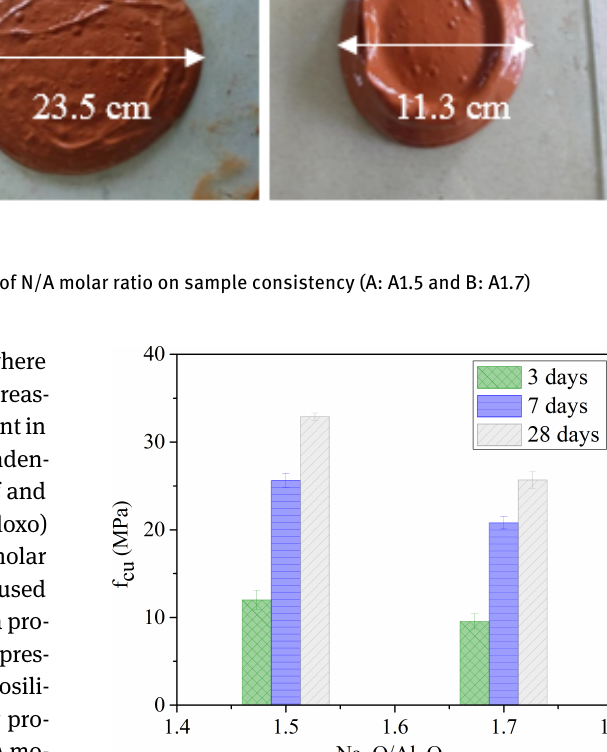
rather than early strength. The 3 days strength for